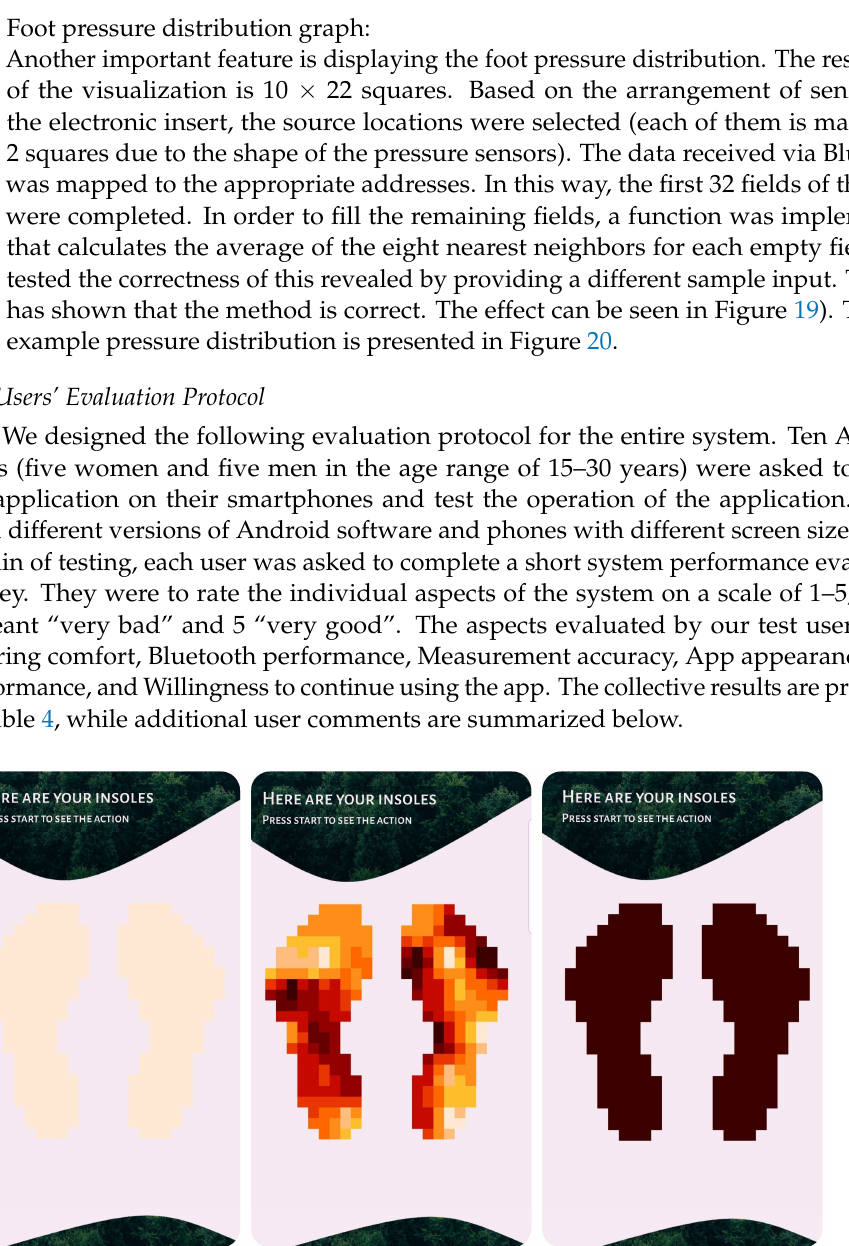
Figure 18. Converting data received via Bluetooth.